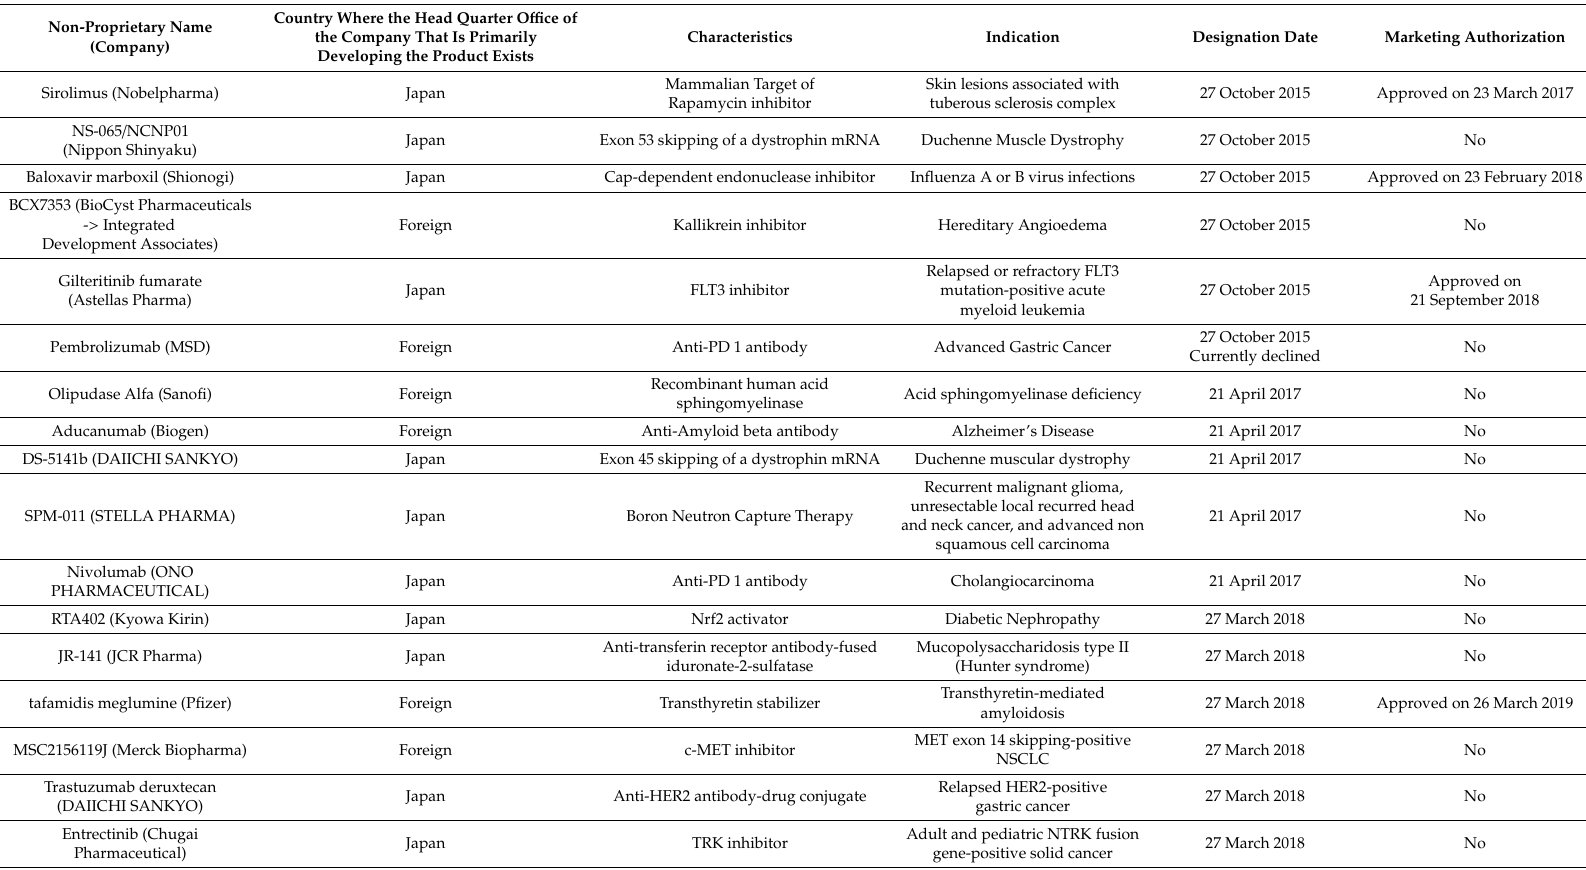
Table 10. Sakigake-designated drugs in Japan as of 31 May